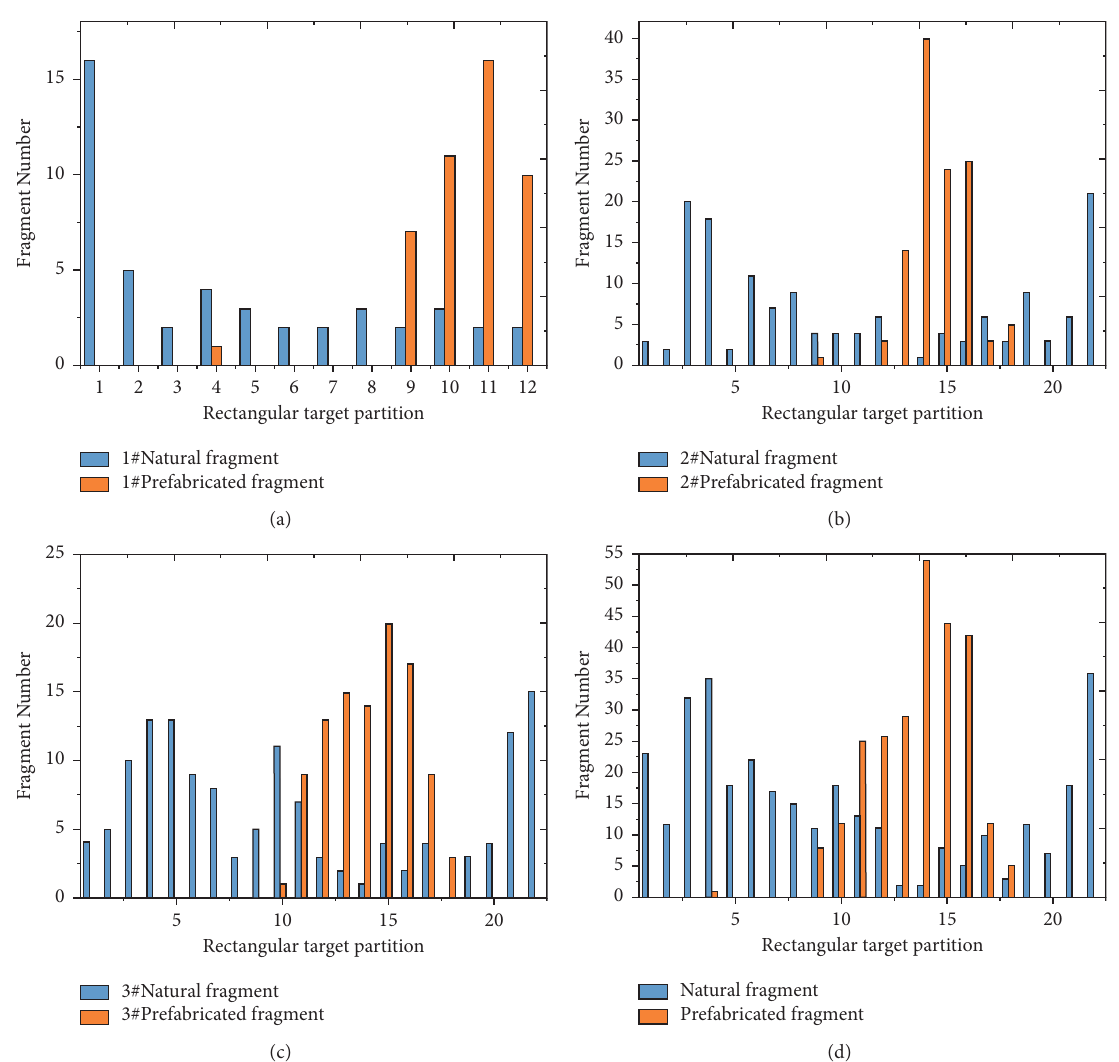
Figure 8: Fragment distributions on witness boards: (a) witness board #1, (b) witness board #2, (c) witness board #3, and (d) joint